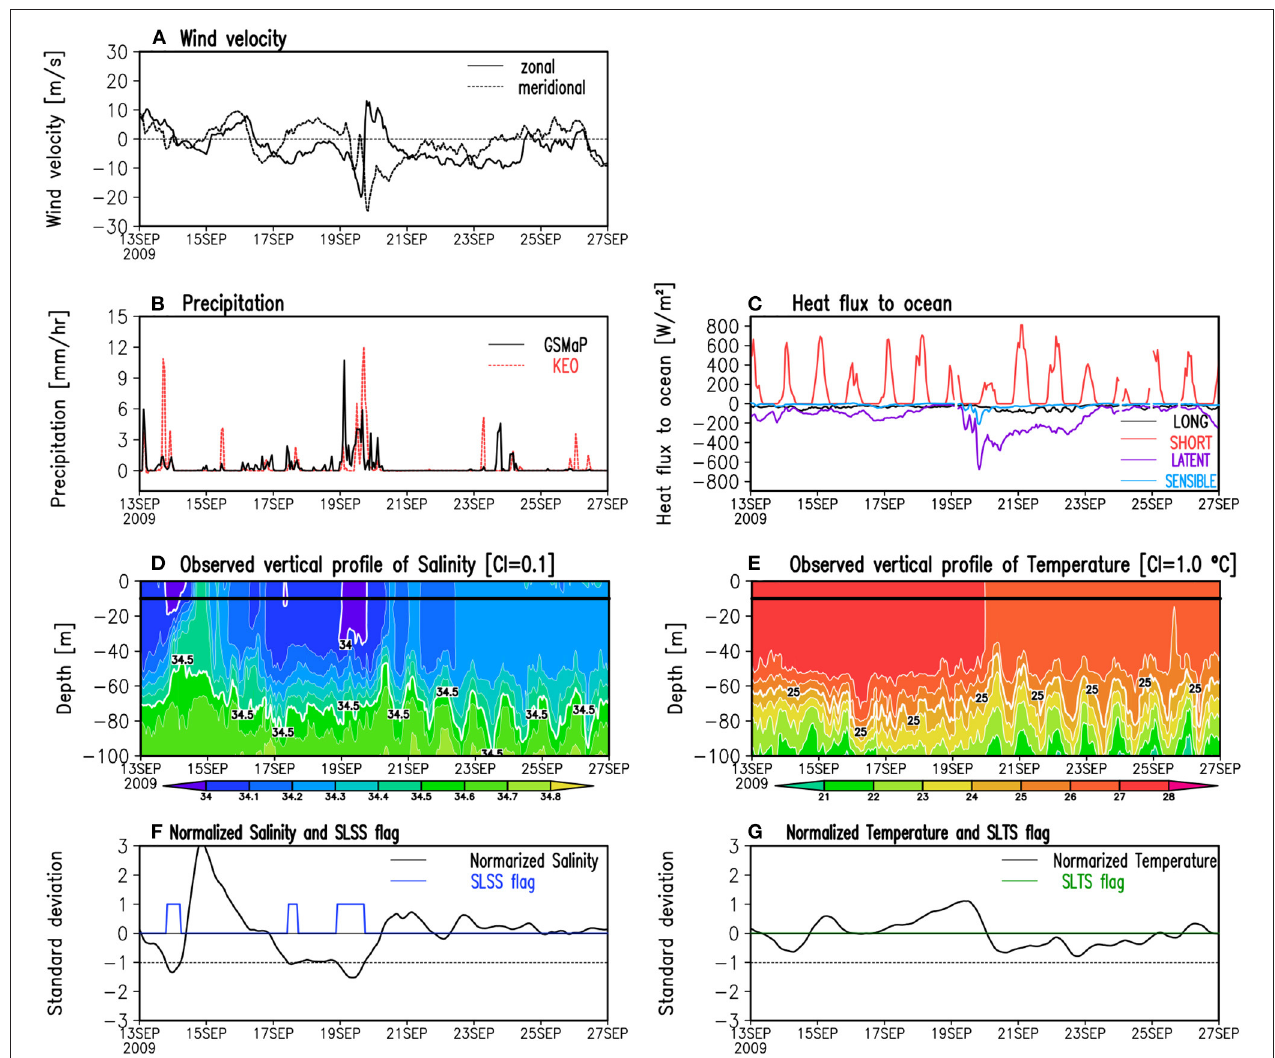
FIGURE 2 | Hourly time series for 13-26 September 2009 when cyclone T0914 (Choiwan) approached the KEO buoy. (A) 10m wind velocity [m/s] in the KEO buoy data with solid and dotted-lines representing the zonal and meridional components, respectively. (B) Precipitation rates [mm/hour] with the red-dotted and black-solid lines representing data from the KEO buoy and GSMaP, respectively. (C) Heat flux [ W / m 2 ] with the black, red, violet, and blue lines representing long-wave radiation, short-wave radiation, and latent and sensible heat-flux components. The vertical profiles of (D) salinity [PSU] and (E) temperature [ ◦ C] from the sea surface to 100m depth, observed by the KEO buoy. The black lines in (F,G) represent the normalized anomalies of salinity and temperature at 10m depth, calculated using equations (2a) and (2b), respectively. The blue and green lines in (F,G) represent the flag parameters indicative of sporadic low salinity and temperature signals (SLSSs and SLTSs) based on equations (3a) and (3b),